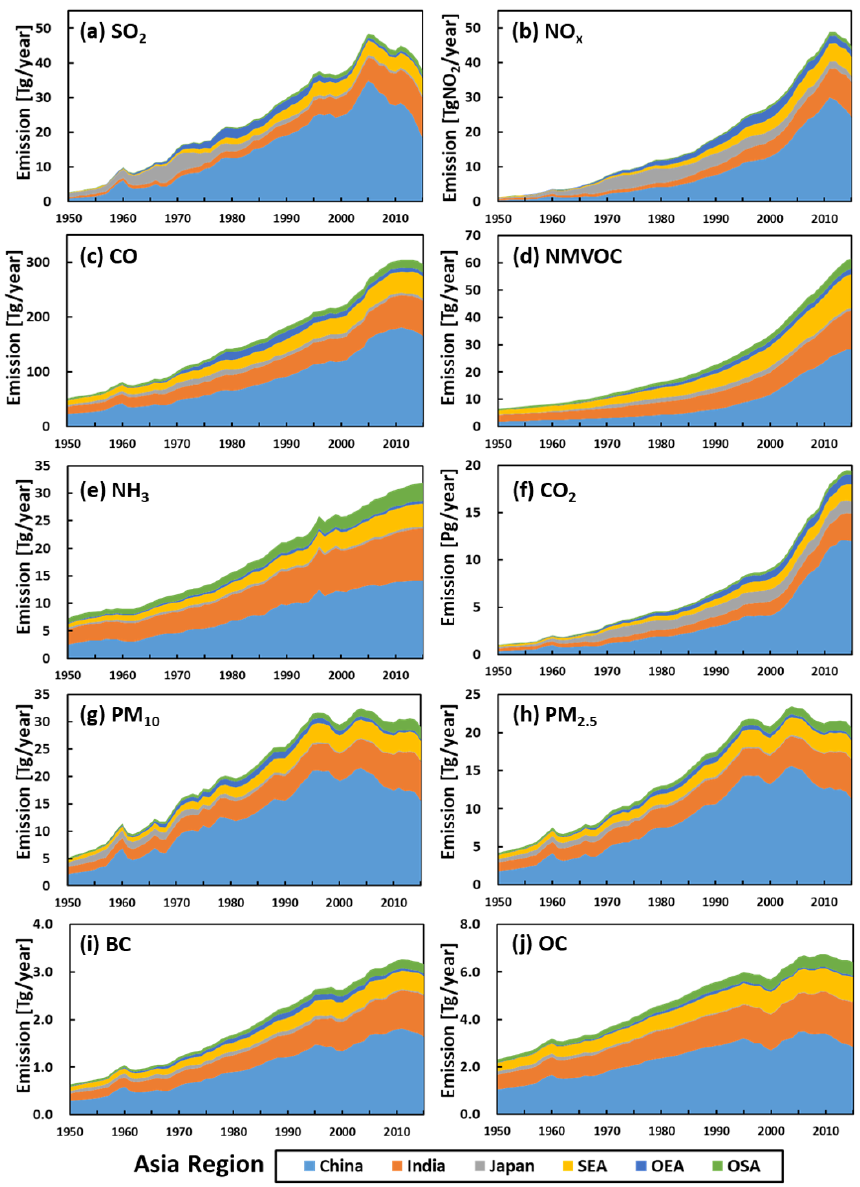
Figure 2. Trends of (a) SO 2 , (b) NO x , (c) CO, (d) NMVOCs, (e) NH 3 , (f) CO 2 , (g) PM 10 , (h) PM 2 . 5 , (i) BC, and (j) OC emissions in Asia during 1950–2015 for each region. See Fig. 1 for countries included in SEA, OEA, and